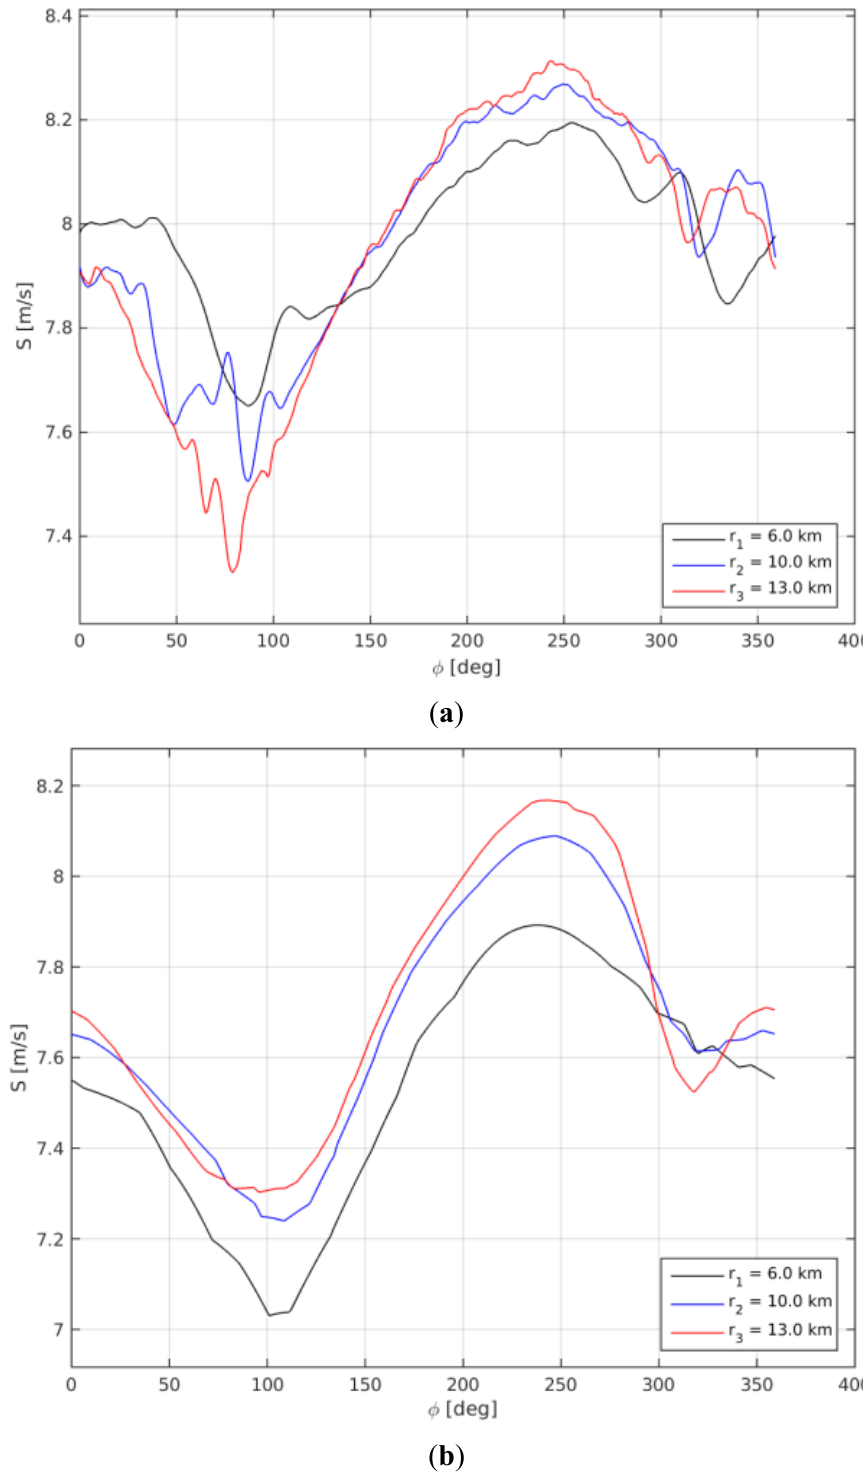
Figure 7. Horns Rev 1 wind speed summations without rotation (mean wind speed gradient) ( S ) based on SAR ( a ) and WRF ( b